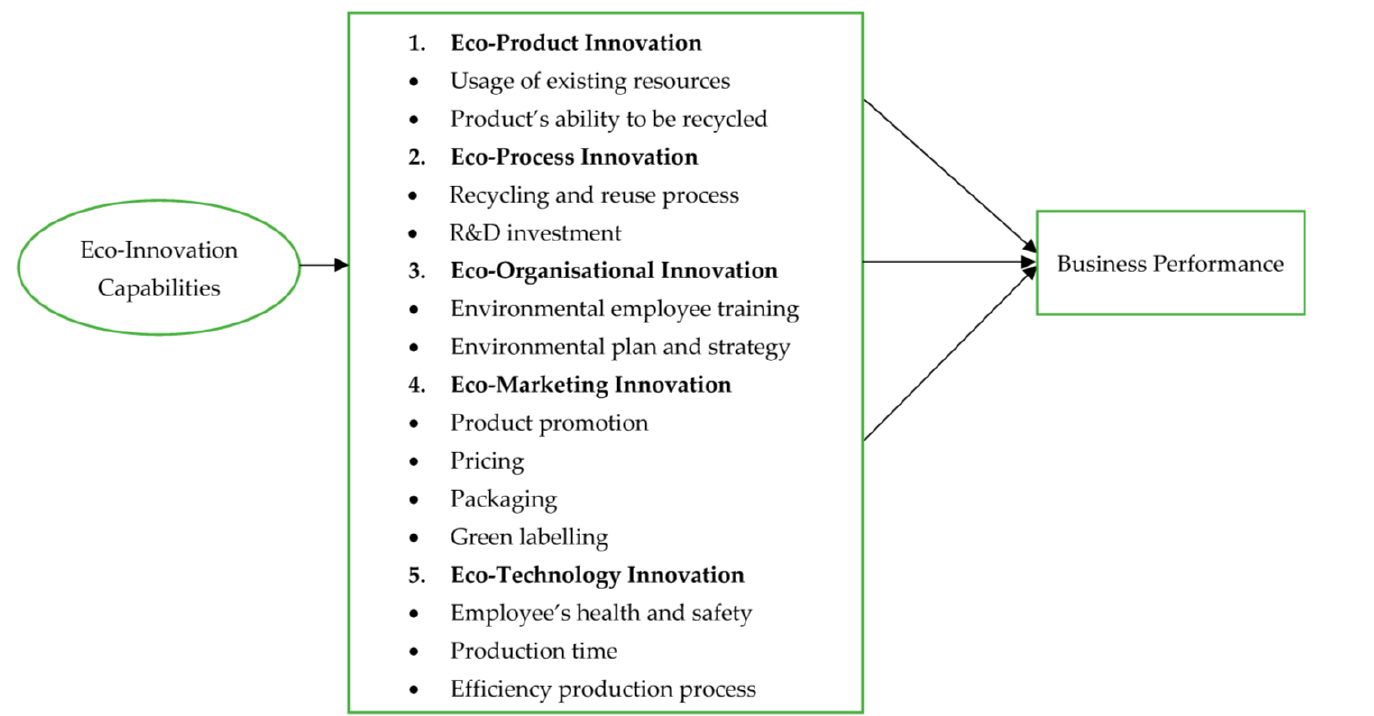
Figure 2. Eco-innovation capabilities implemented by manufacturing SMEs in Malaysia to sustain the business performance.